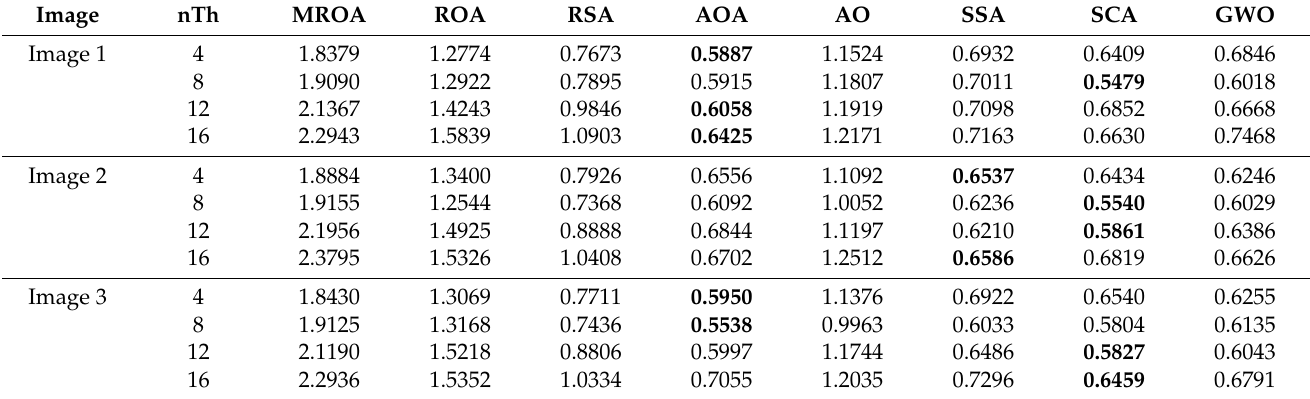
Table A8. The CPU time for the MROA and comparison